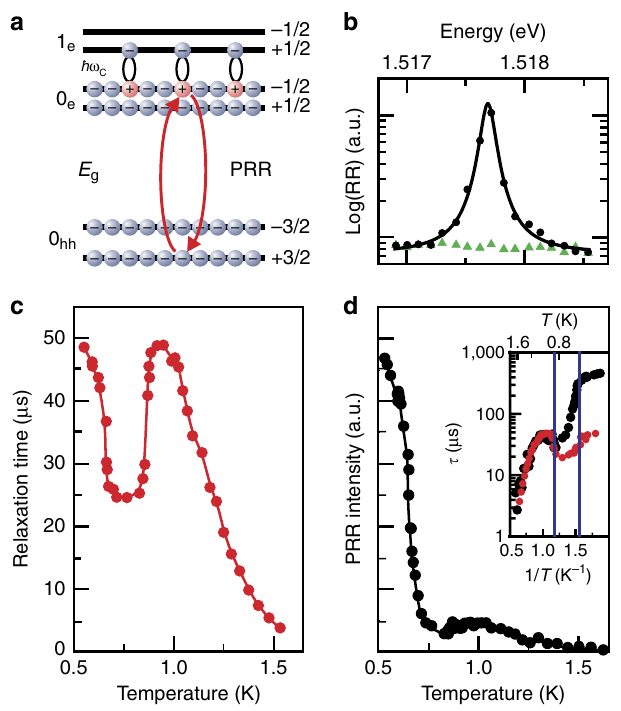
Figure 1 | Phase transition in non-equilibrium 2D electron system. ( a ) Diagram of 2D single-electron energy states in magnetic field ( ± 1/2, and ± 3/ 2 are the spins of the electrons in the conduction band and heavy holes in the valence band). The black ellipses illustrate schematically how the photoexcited Fermi-holes in the zero electron Landau level (0 e ) couple with the photoexcited 1 e electrons to form spin-triplet CMEs. The red arrows denote the optical transition (0 h (cid:2) 0 e ) of photoinduced resonant reflection (PRR). ( b ) Resonant reflection (RR) spectrum of the equilibrium 2D electron system (green triangles) and that of the system driven from equilibrium by photoexcitation of the CME ensemble (black dots). The solid line is a Lorenz approximation to the experimental points. ( c ) Temperature dependence of CME relaxation time t ( T ) (dots). The solid line is drawn for convenience. ( d ) Temperature dependences of PRR intensity I ( T ) in the conditions of stationary photoexcitation (dots). The solid line is drawn for convenience. The inset presents comparison between t ( T ) (red dots) and I ( T ) (black dots) in the logarithmic scale ( I ( T ) is multiplied by a constant so that t ( T ) and I ( T ) coincide at 1K).